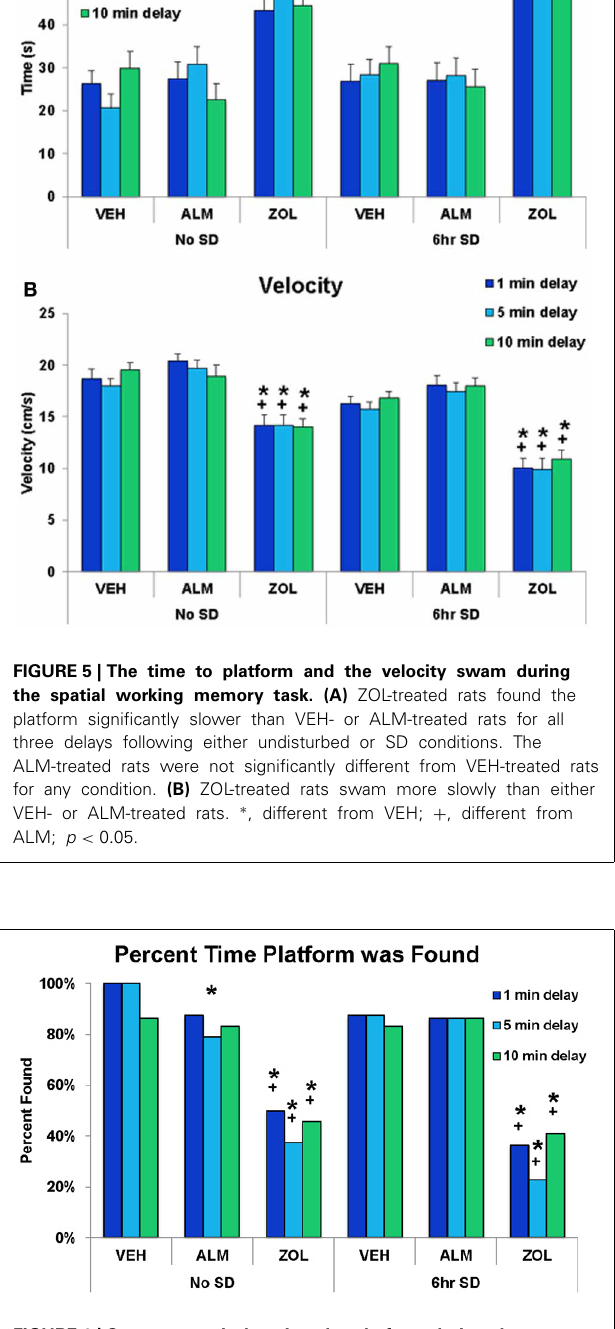
FIGURE 6 | Success rate in locating the platform during the test trials in the spatial working memory task. ZOL-treated rats found the platform significantly fewer times compared to VEH- or ALM-treated rats for all three delays and following both the undisturbed and SD conditions. In each trial, an individual rat either found or didn’t find the platform; thus, there is no variation to represent as error bars in the graphs. ∗ , different from VEH; + , different from ALM; p < 0 . 05.